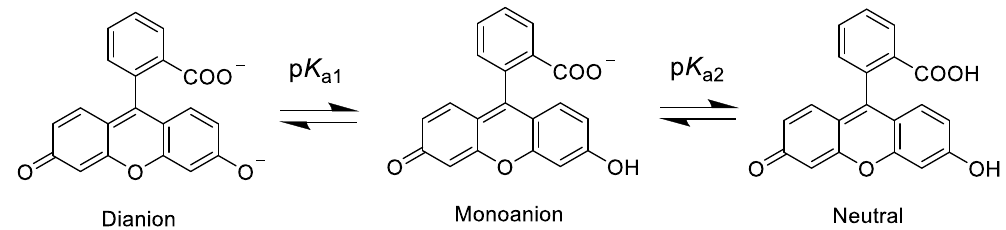
Figure 1. Scheme illustrating the equilibrium between the neutral, monoanionic, and dianionic forms of fluorescein.